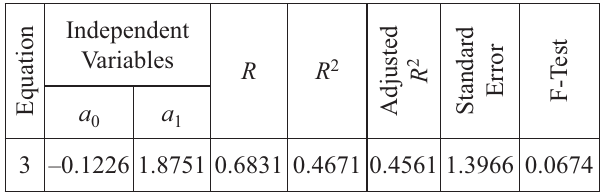
Table 2 . Regression Result of Forced Sale Values